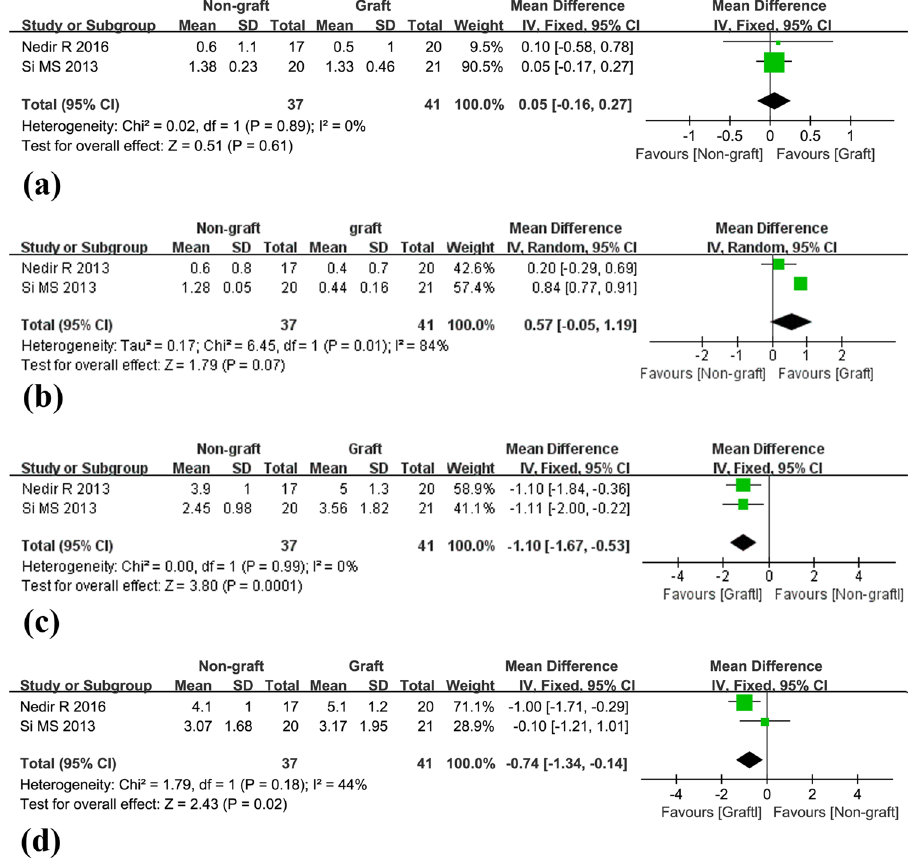
Figure 4. Forest plots of MBL and EsBG. ( a ) Forest plot of MBL at 36 months for the non-graft vs. the graft group. ( b ) Forest plot of MBL at 12 months for the non-graft vs. the graft group. ( c ) Forest plot of EsBG at 12 months for the non-graft vs. the graft group. ( d ) Forest plot of EsBG at 36 months for the non-graft vs. the graft